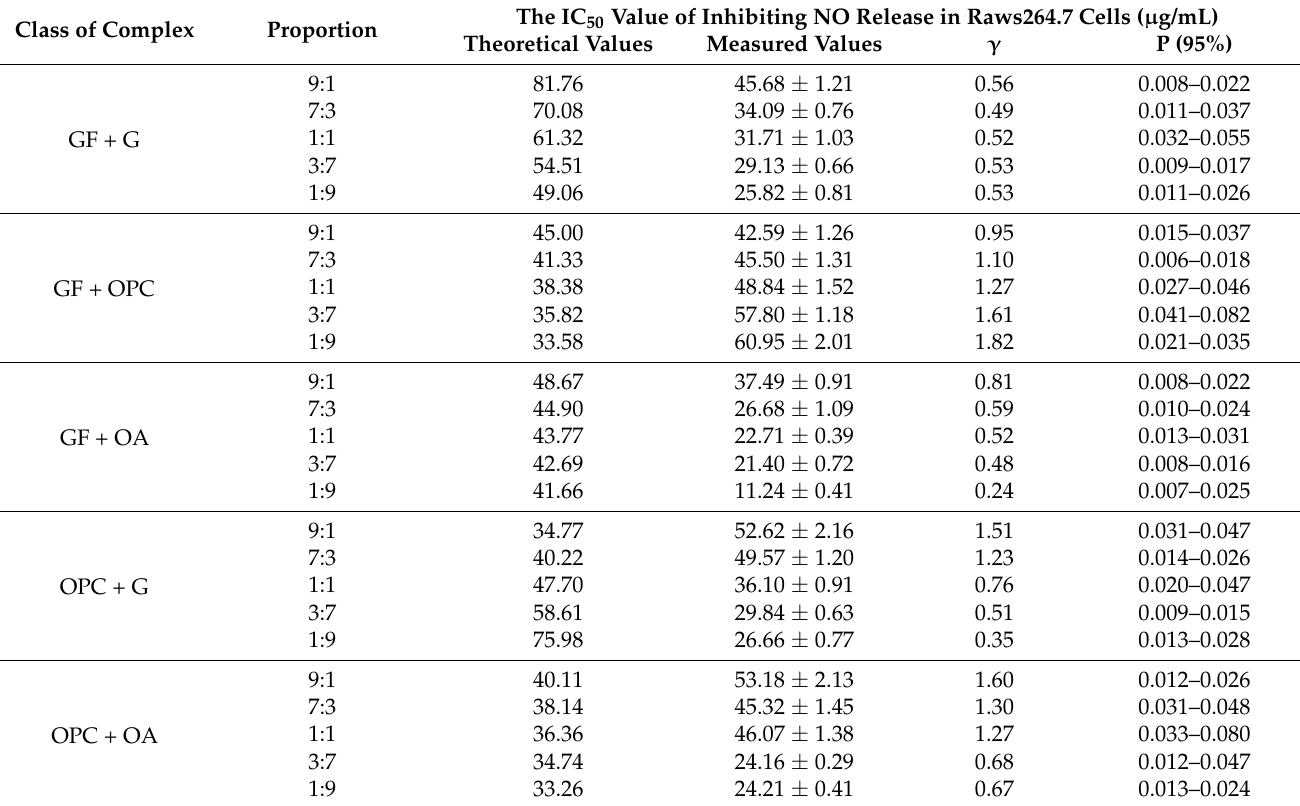
Table 2. Each functional component of EGB was combined with statistical analysis